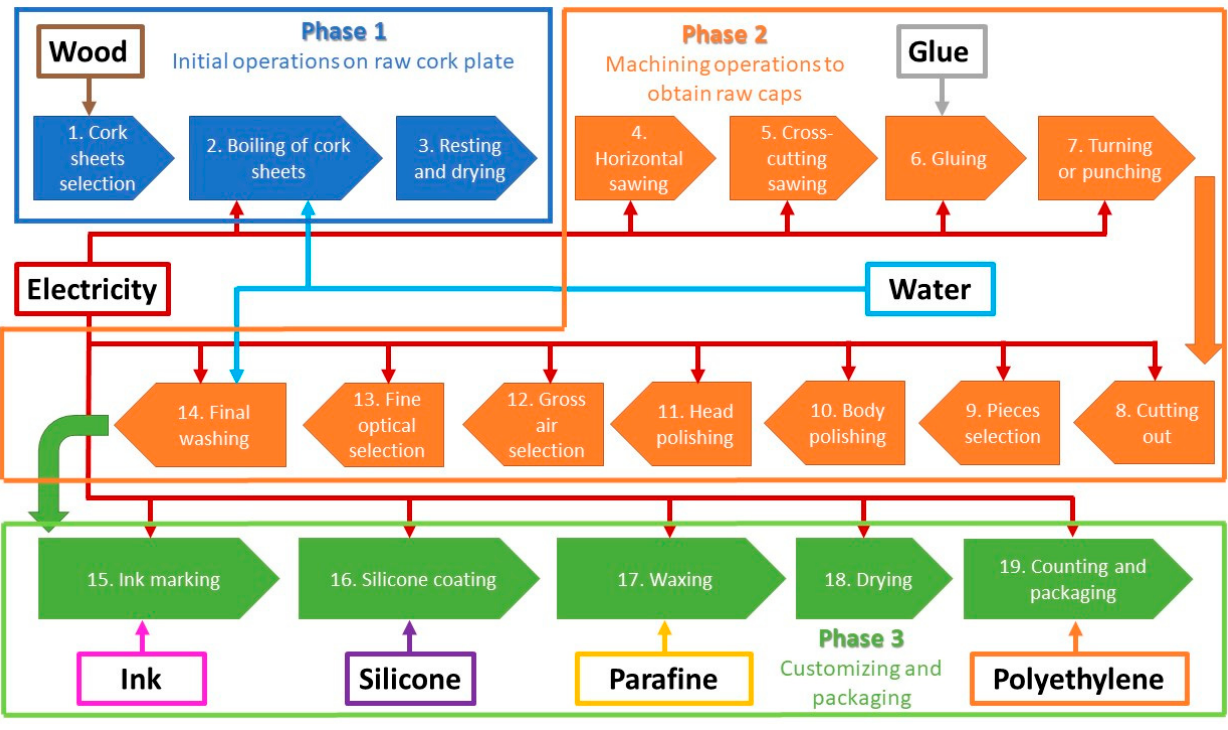
Figure 3. Flowchart. Table 1. Consumptions for 1000 kg raw material used to produce 2-piece stoppers with dimensions of 24 × 44—Drilled (Perforated) method.